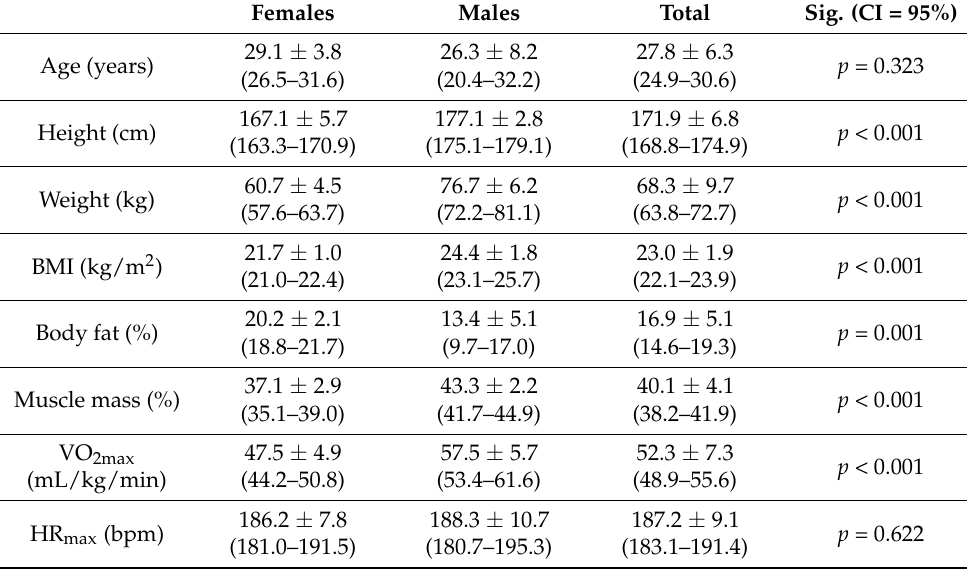
Table 1. Padel players’ characteristics.